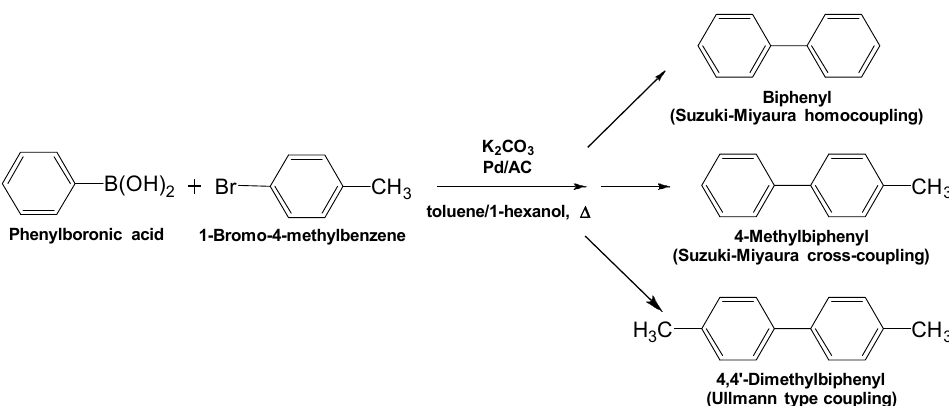
Figure 2. The synthesis mechanism of 4-dimethylbiphenyl (target), biphenyl (by-product) and 4,4 ′ -dimetyl- biphenyl (by-product).